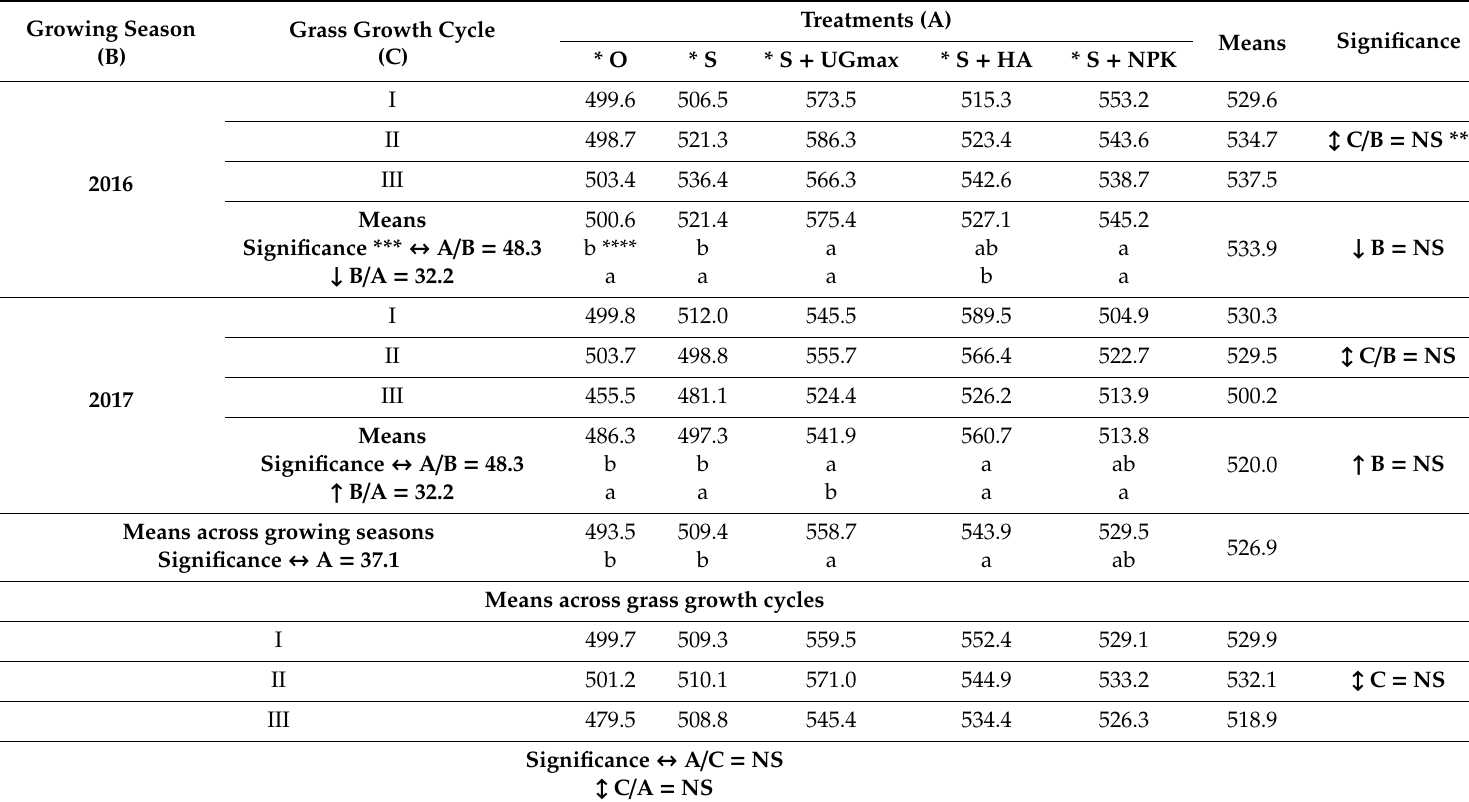
Table 4. The e ff ect of treatments on mean neutral detergent fiber (NDF) content in Festulolium braunii dry matter across grass growth cycles and growing seasons (g · kg − 1 ).